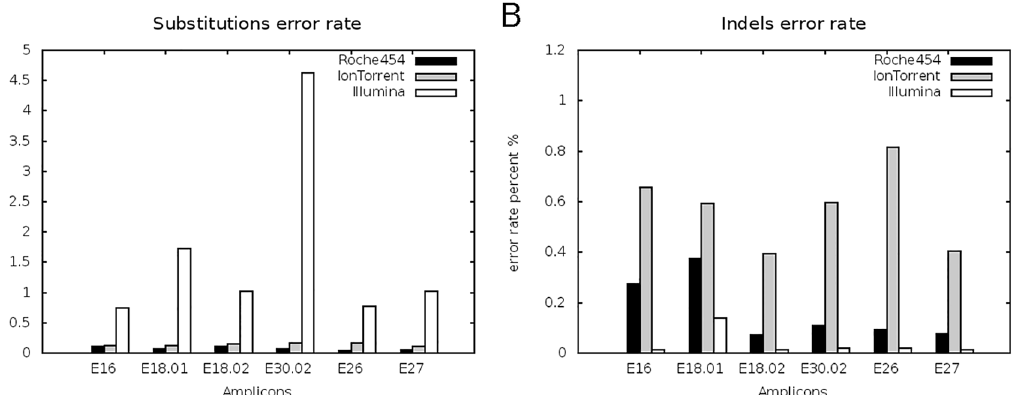
Fig 4. Platform comparison — amplicon-specific error rates. HTS platform-specific substitution (A) and Indel (B) error rates for amplicon libraries sequenced by 454 (black), Illumina (white), and IonTorrent (light grey) platform are displayed for single amplicons covering corresponding exons of the CREBBP